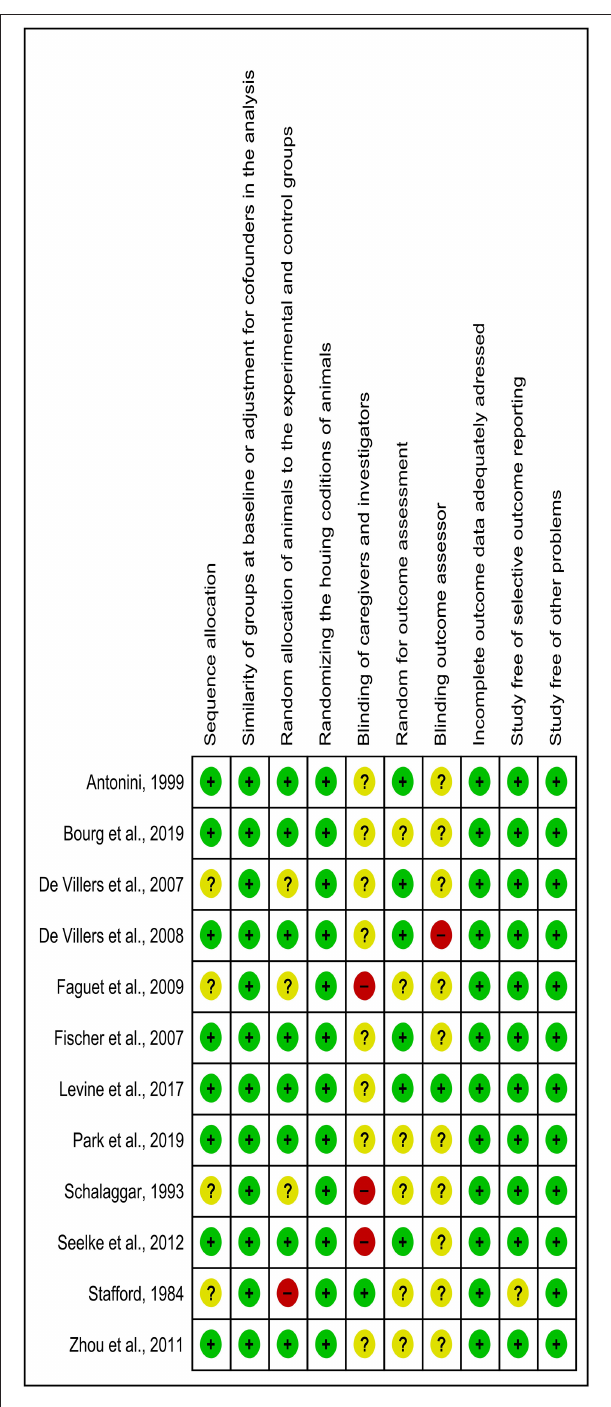
FIGURE 3 | Risk of bias chart of studies included in the qualitative analysis by using 10 domains. Green, yellow, and red colors indicate a low, unclear, and high risk of bias,